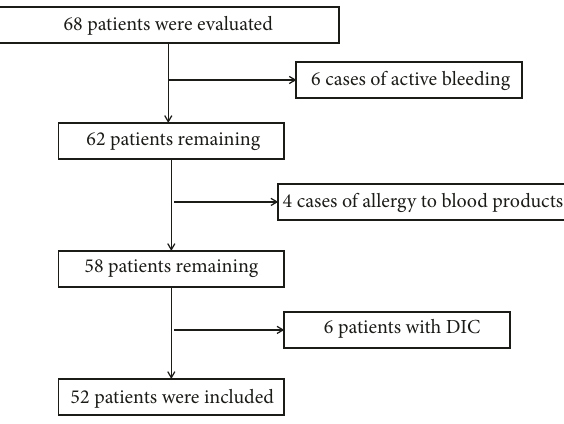
Figure 1: Flowchart of included